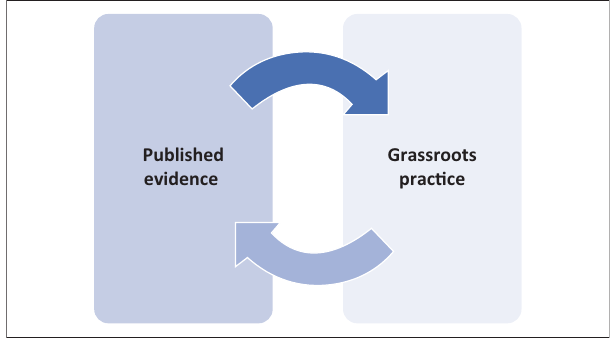
FIGURE 1: Diagrammatic presentation of our two interdependent